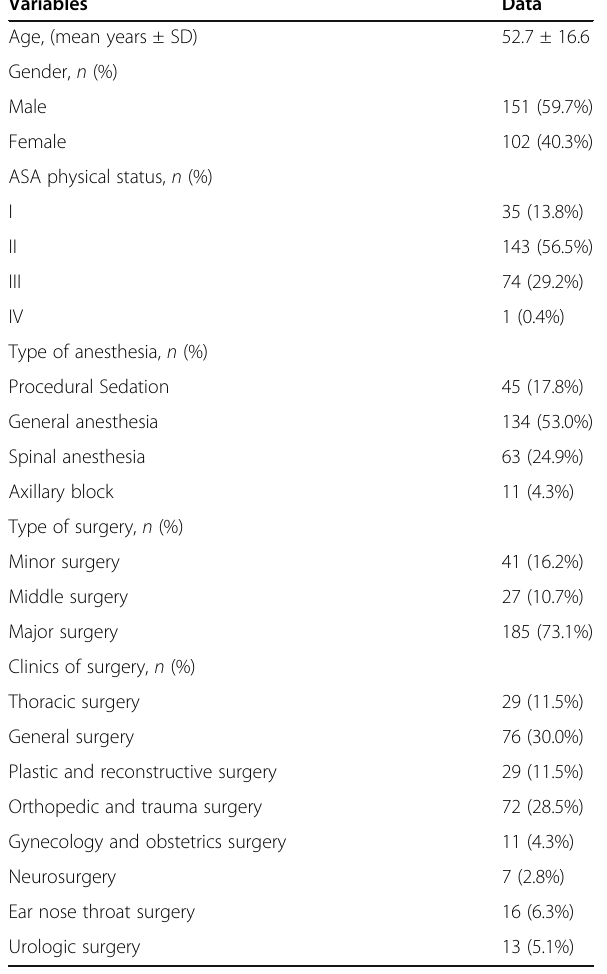
Table 3 Distribution of COVID-19 Reporting and Data System CO-RADS (CO-RADS) scale, Total severity score (TSS), and